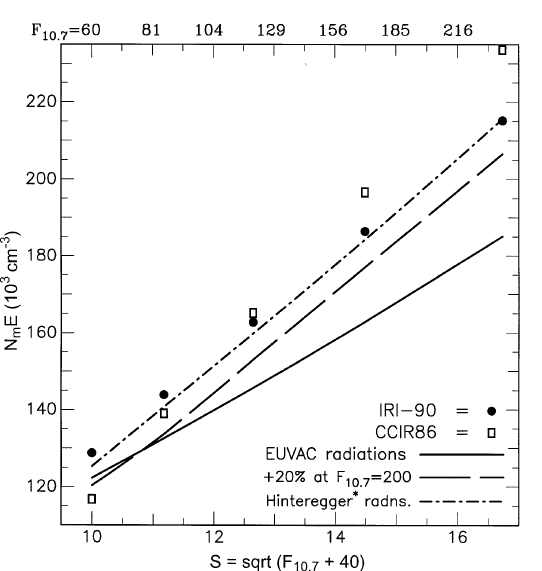
Fig. 9. The variation of N (cid:109) E with solar flux for summer ( circles ) and winter ( triangles ). Results are for a latitude of 40 ° N, at a constant solar zenith angle (cid:115) " 65 ° . Solid symbols are from the IRI empirical model. Continuous and dotted lines are from model calculations